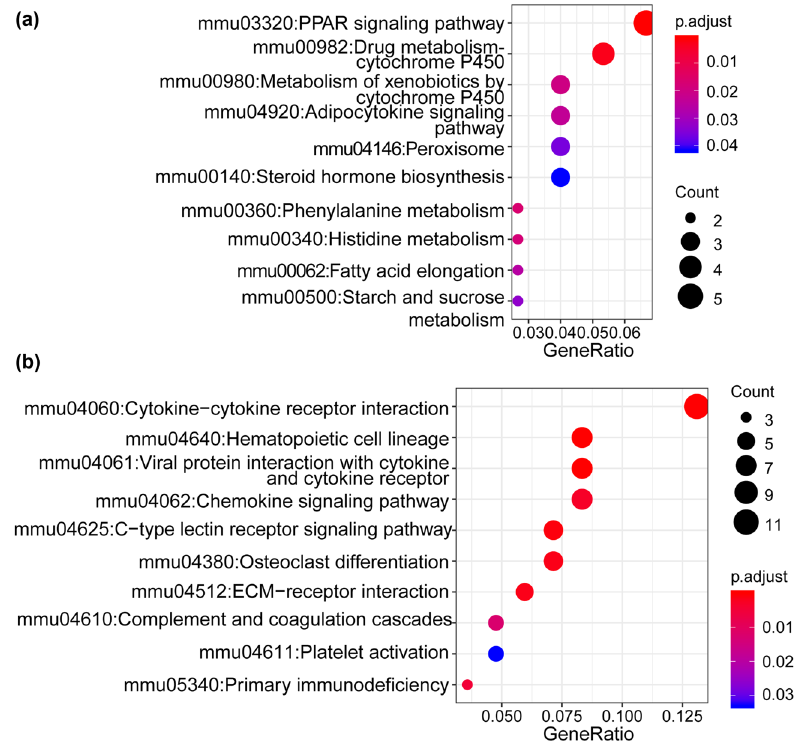
Figure 2: The KEGG pathway enrichment analysis of DEGs ( a ) and ( b ) . The top ten KEGG pathways of upregulated and downregulated DEGs,